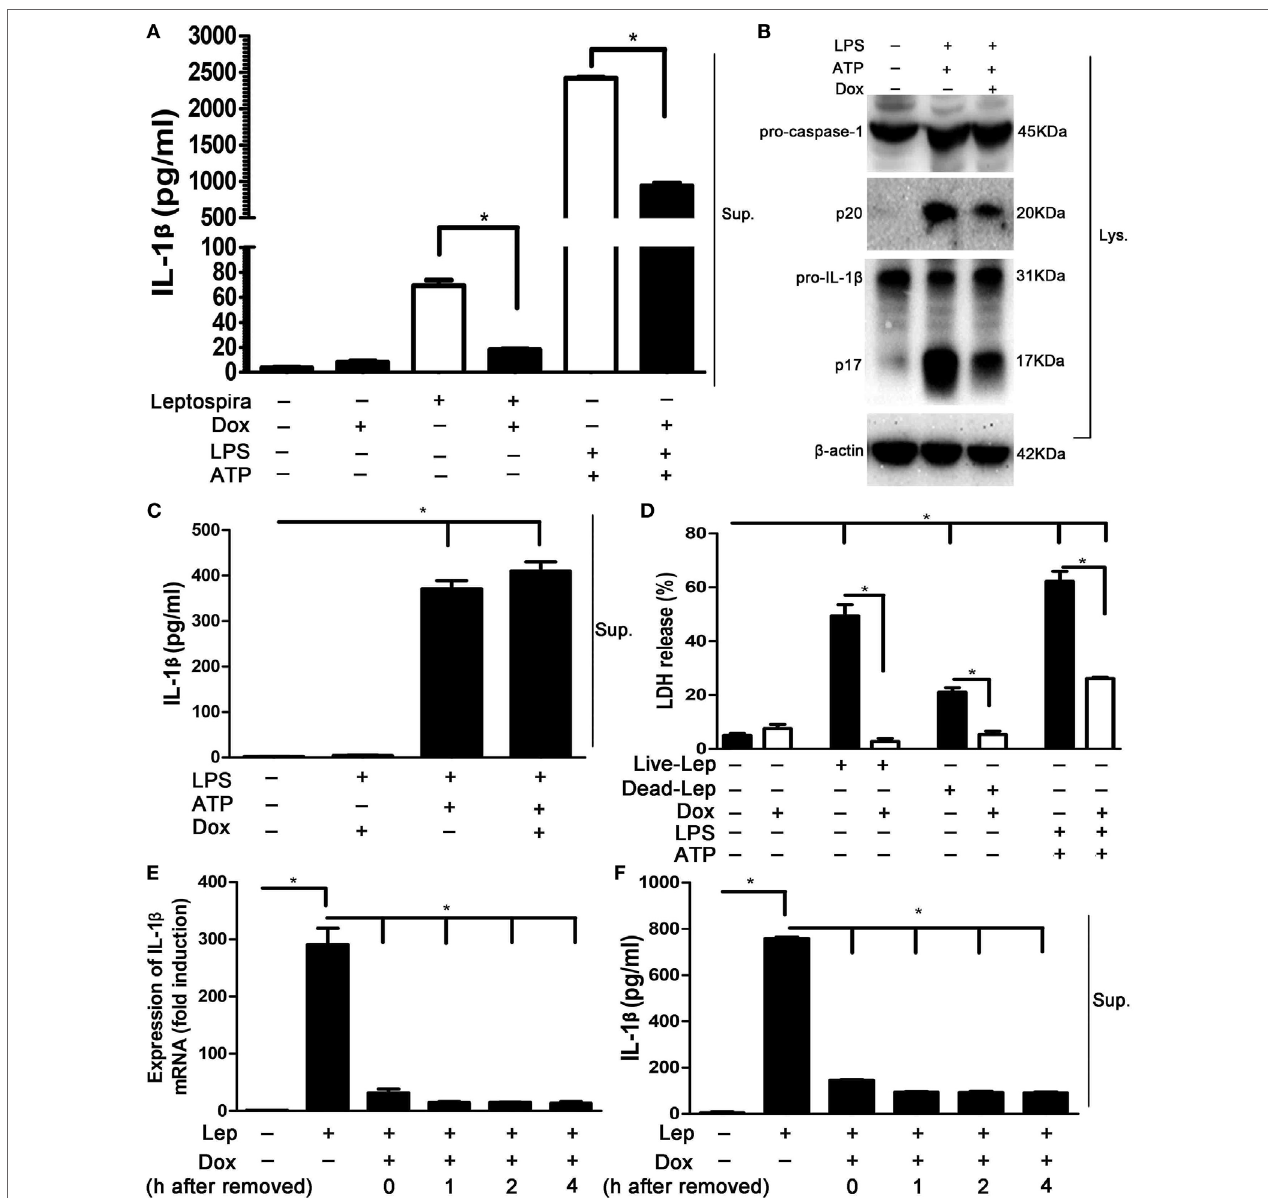
FigUre 5 | The suppression effect of doxycycline to NLRP3 inflammasome was not limited to leptospira stimulation. (a) The protein levels of IL-1 β in cell supernatants (Sups) were measured by enzyme-linked immunosorbent assay (ELISA). (B) The activation of caspase-1 and the release of mature IL-1 β in J774A.1 cells extracts (Lysate) were analyzed by immunoblot. The β -Actin protein was used as a control. (c) The releases of IL-1 β in lipopolysaccharide-primed J774A.1 cells Sups were measured by ELISA. (D) The level of cell death was assessed by measuring release of lactate dehydrogenase. (e) The expression of IL-1 β mRNA in live leptospira-infected J774A.1 cells was analyzed by quantitative real-time polymerase chain reaction. The mRNA levels of IL-1 β in J774A.1 cells were normalized to the expression of the housekeeping gene GAPDH. (F) The releases of IL-1 β in live leptospira-infected J774A.1 cells Sups were measured by ELISA. Bars show the levels of cytokines with mean ± SD ( n = 3) and analyzed by the one-way ANOVA. * p <